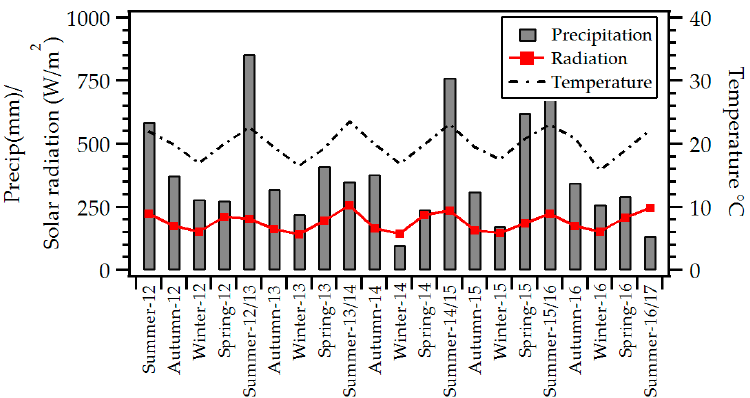
Figure 5. Seasonal variations in precipitation, temperature, and incoming solar radiation in the Metropolitan Area of São Paulo, between 2012 and 2016 [41].